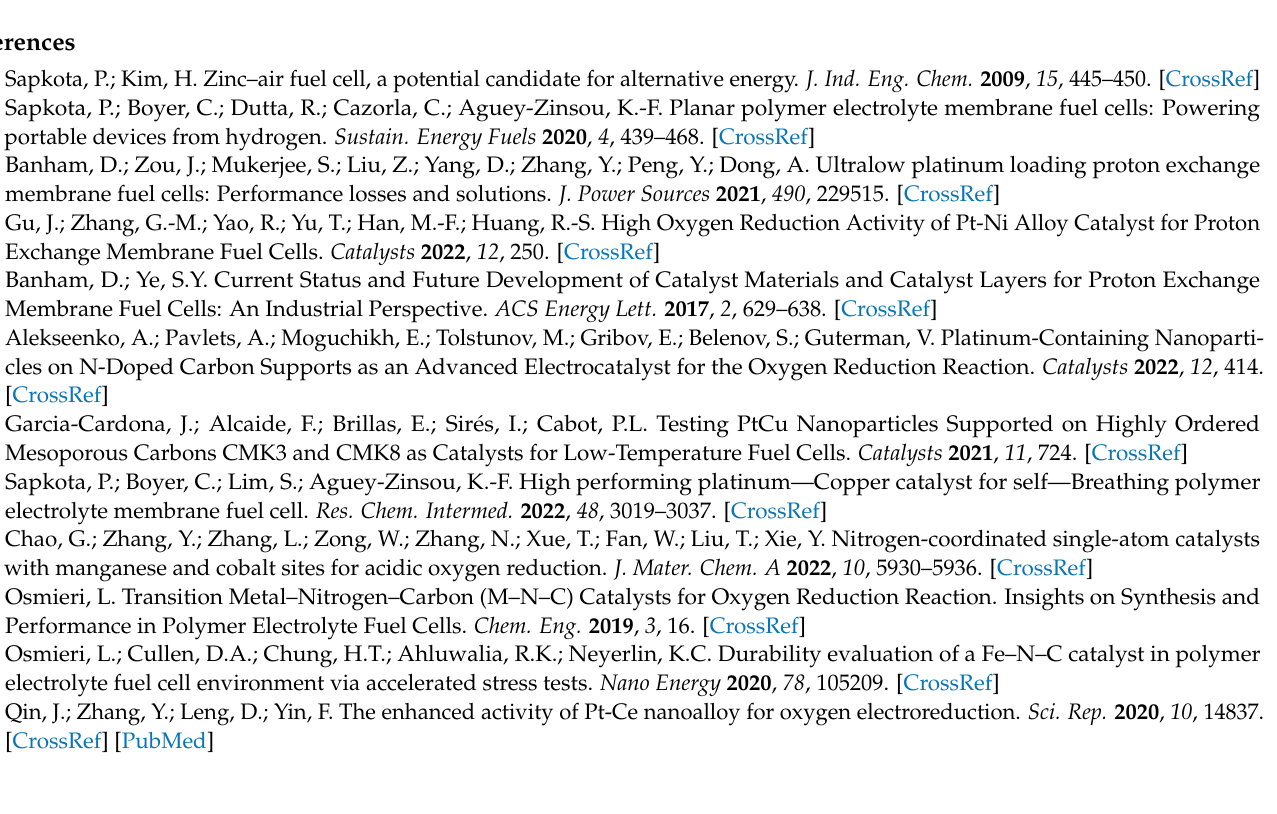
Figure S9: LSV of Pt/VC at various rotational speed, Table S1: Comparison of ORR performance of various catalysts